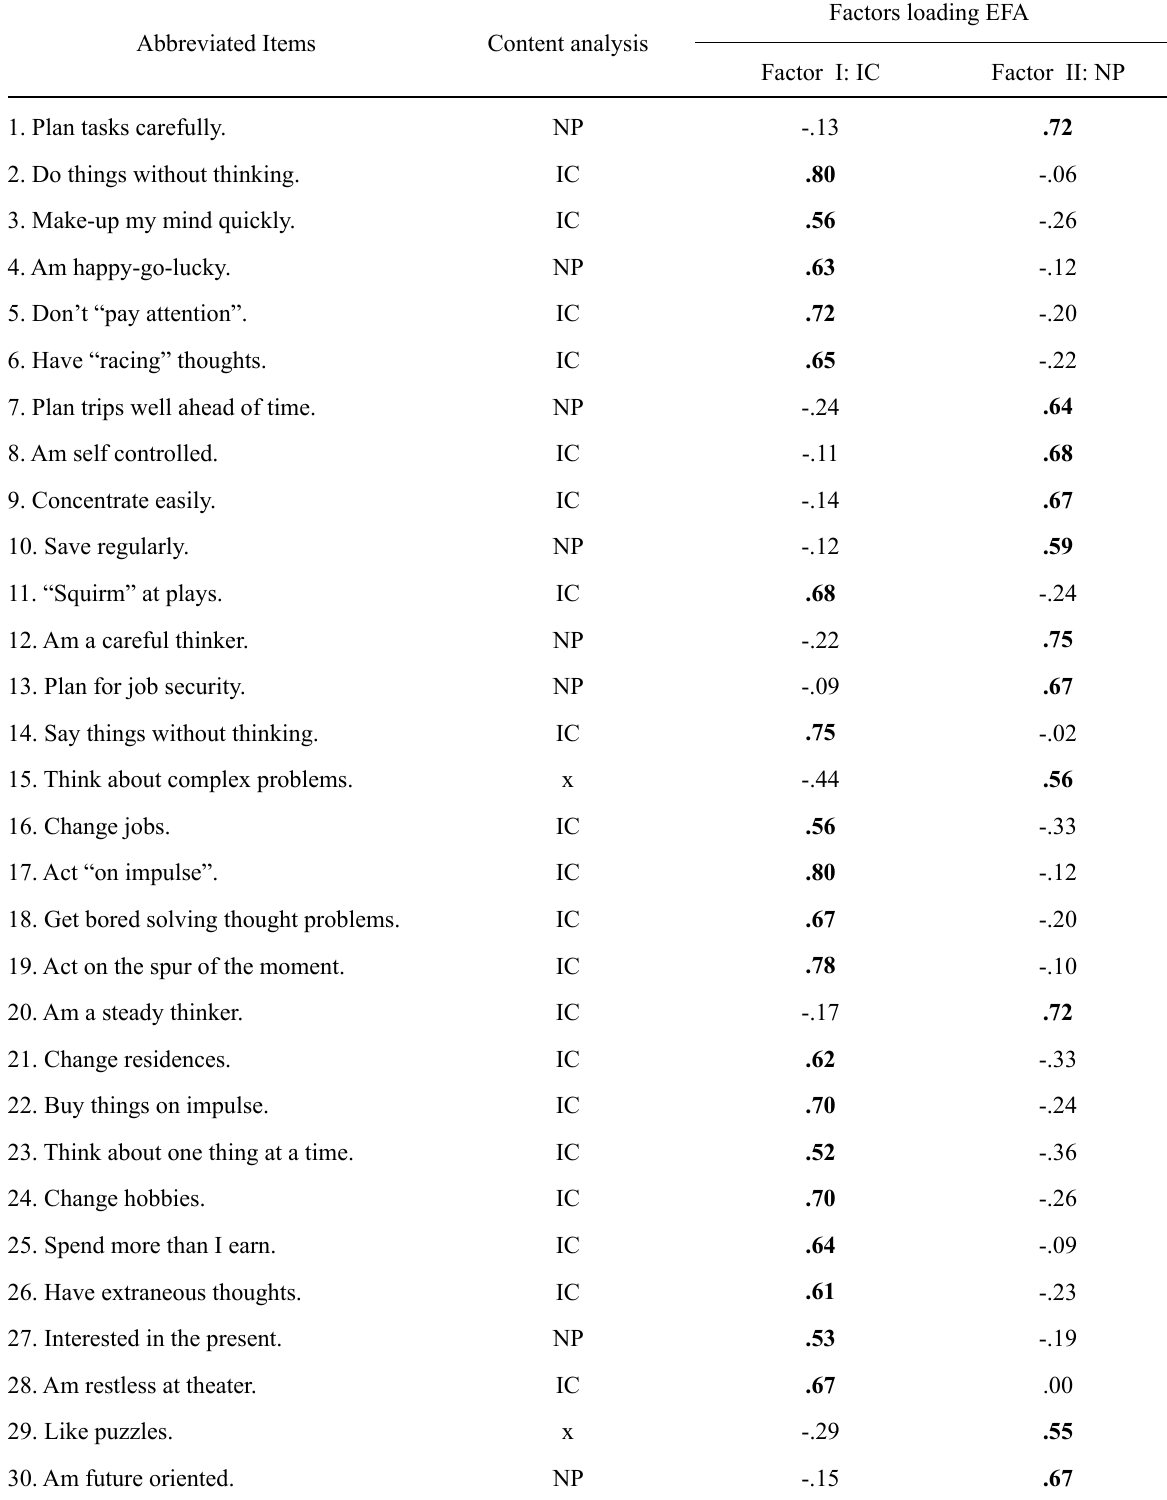
BIS-11 Items Organization based on Content and EFA